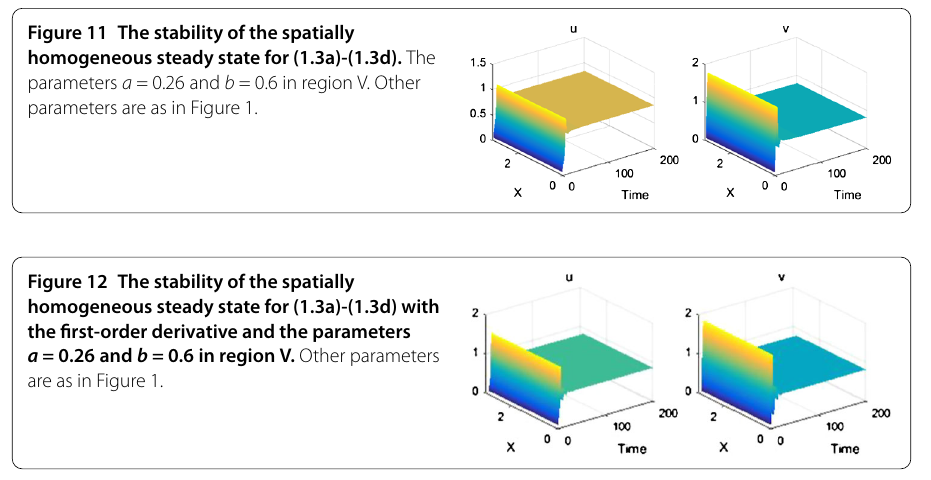
Figure 11 The stability of the spatially homogeneous steady state for (1.3a)-(1.3d). The parameters a = 0.26 and b = 0.6 in region V. Other parameters are as in Figure 1.